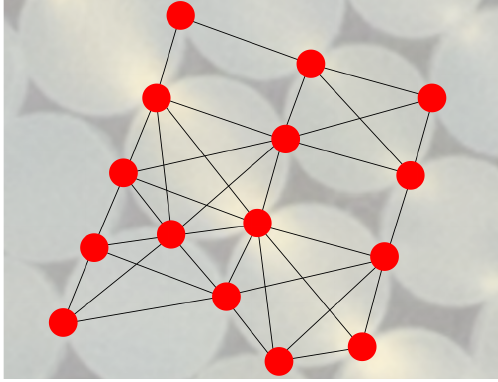
Figure 2. Schematic of the network model overlaid on an ex- periment picture. Contact points are the nodes, linked by edges within grains. A force chain is slightly visible